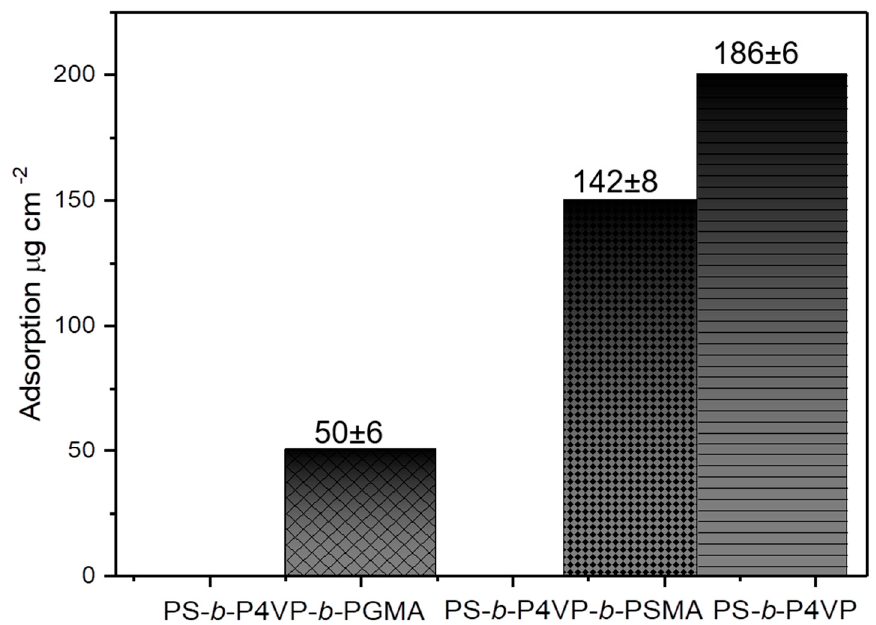
Figure 8. Protein adsorption of hemoglobin of PS 74 - b -P4VP 26162 , PS 71 - b -P4VP 26 - b -PSMA 3145 , and PS 71 - b -P4VP 26 - b -PGMA 3145 membranes at pH 7.4.